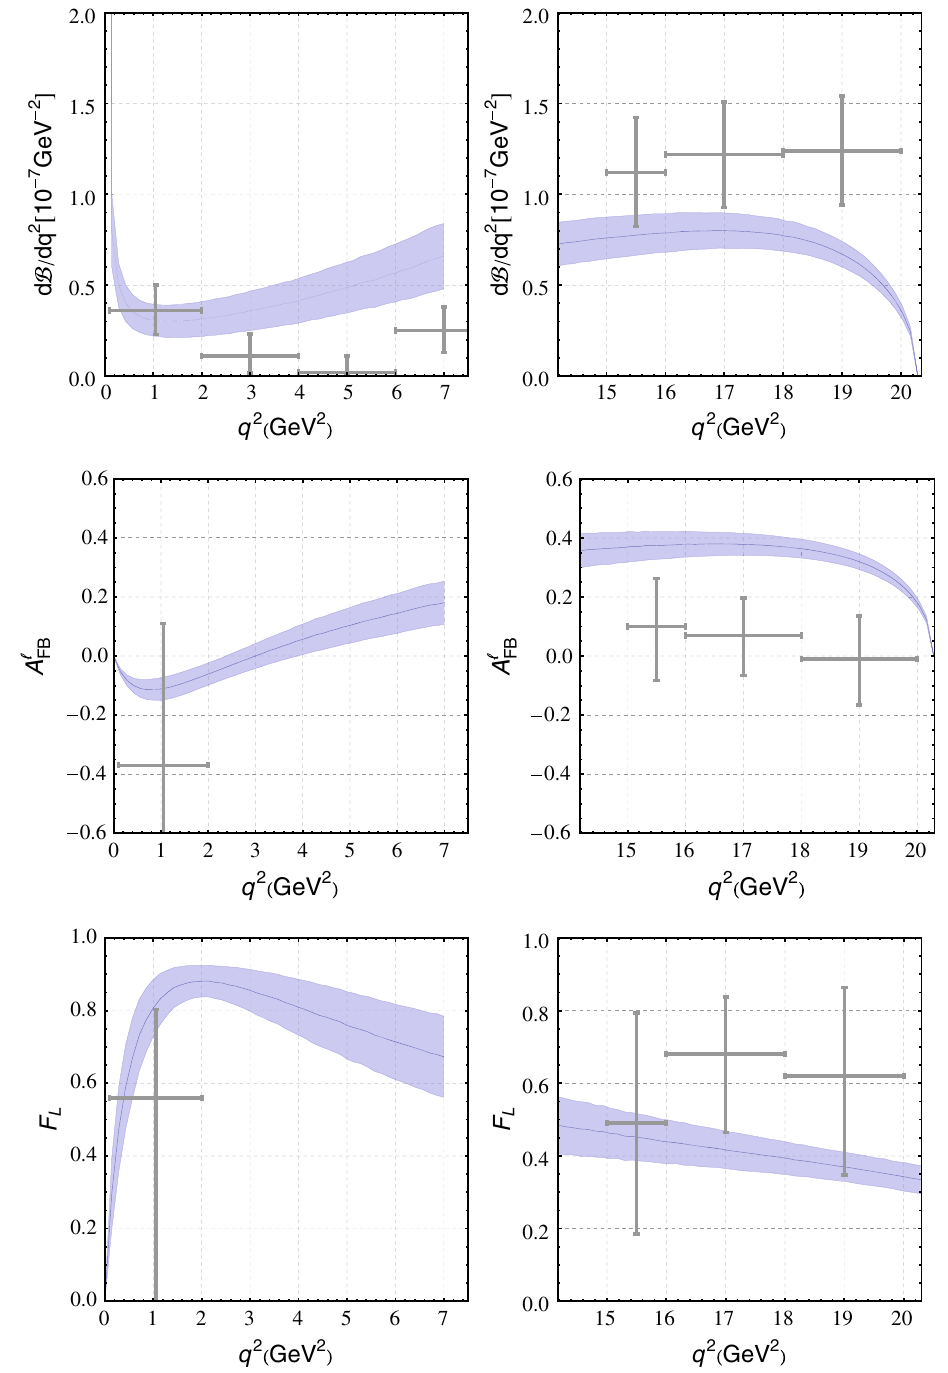
Fig. 1 The SM predictions of differential branching ratio, leptonic forward-backward asymmetry A (cid:3) F L . The bands correspond to the uncertainties dominated by the (cid:2) b → (cid:2) form-factors. The points shown by cross marks indicate LHCb data